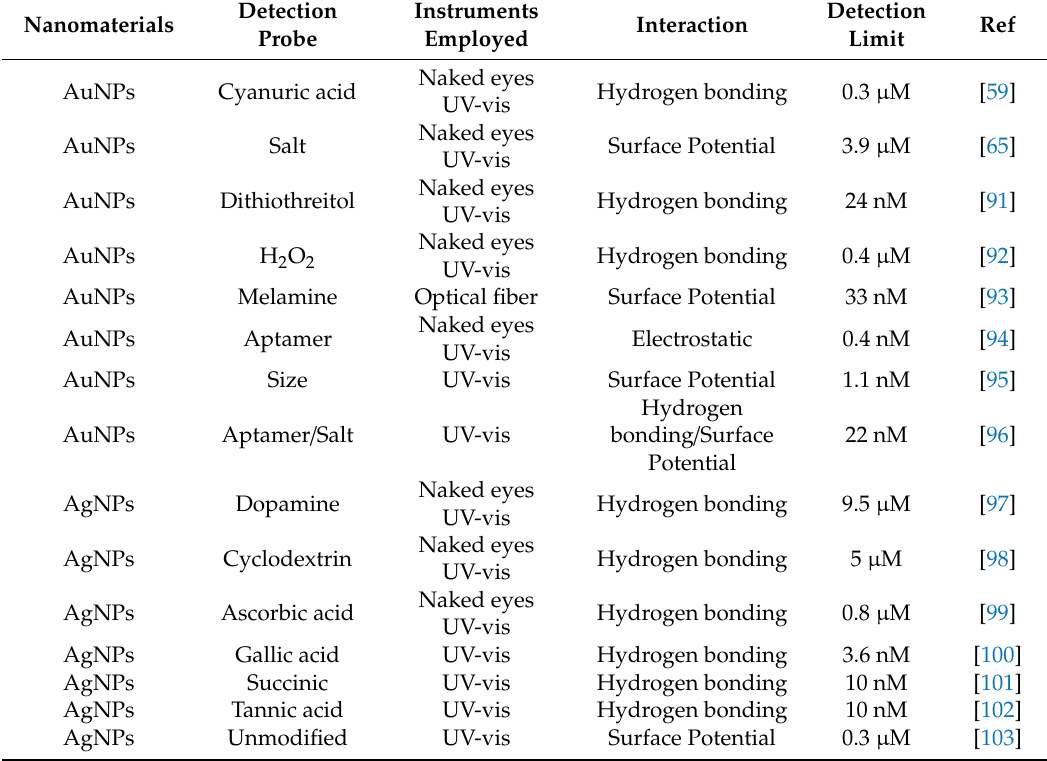
Table 1. Recent reported AuNPs / AgNPs-based colorimetric biosensors for melamine detection.